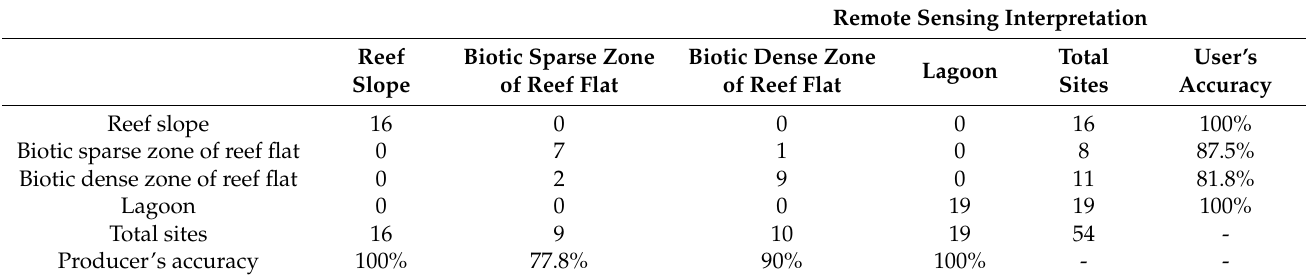
Figure 2. The geomorphic and reef flat ecological map of the surveyed reefs in ( a ) Xisha Islands, ( b ) Dongsha Islands, and ( c ) Nansha Islands. Table 1. Confusion matrix for geomorphic and reef flat ecological mapping in the Xisha Islands. Overall accuracy = 94.4%.